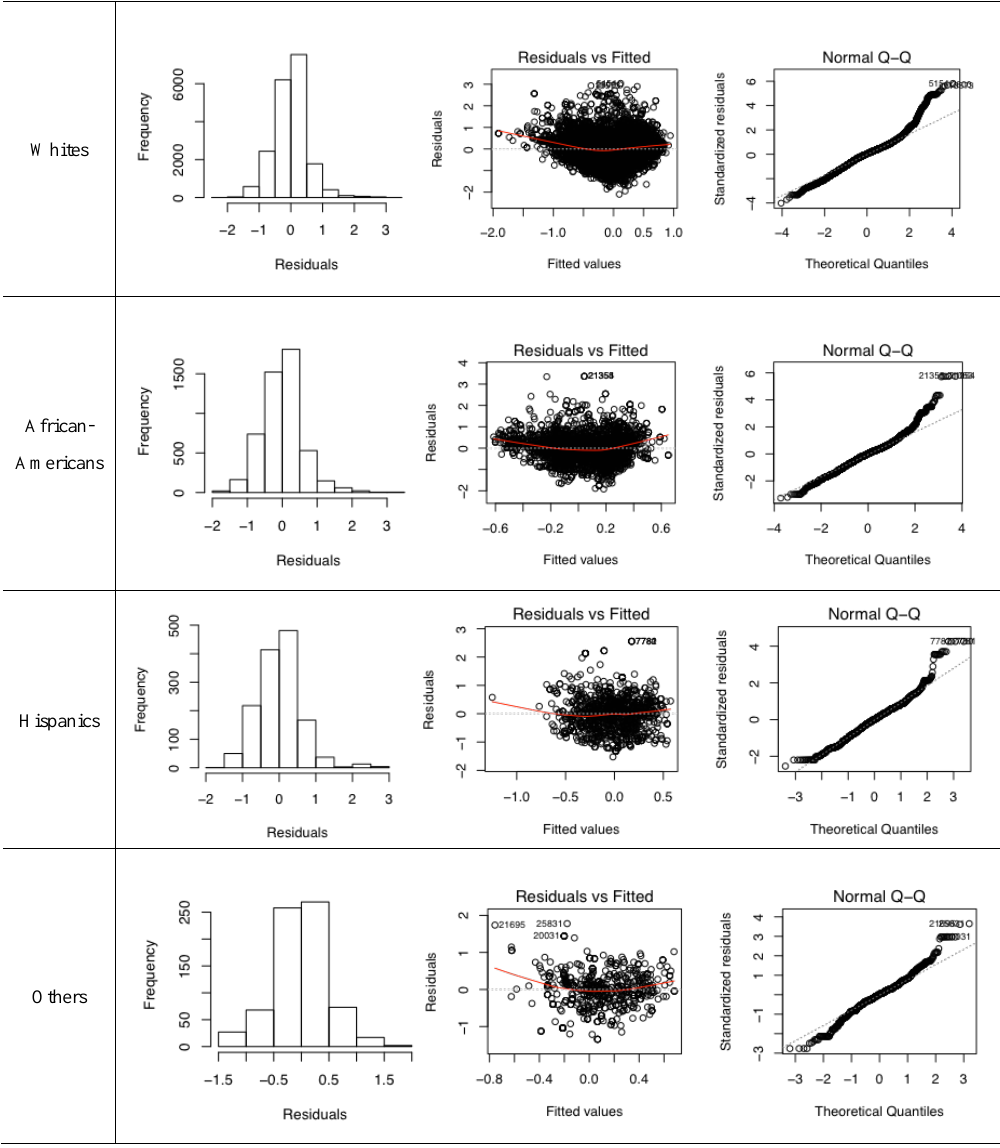
Figure 4. Diagnostic plots of multiple linear regression models with log-transformed variables.